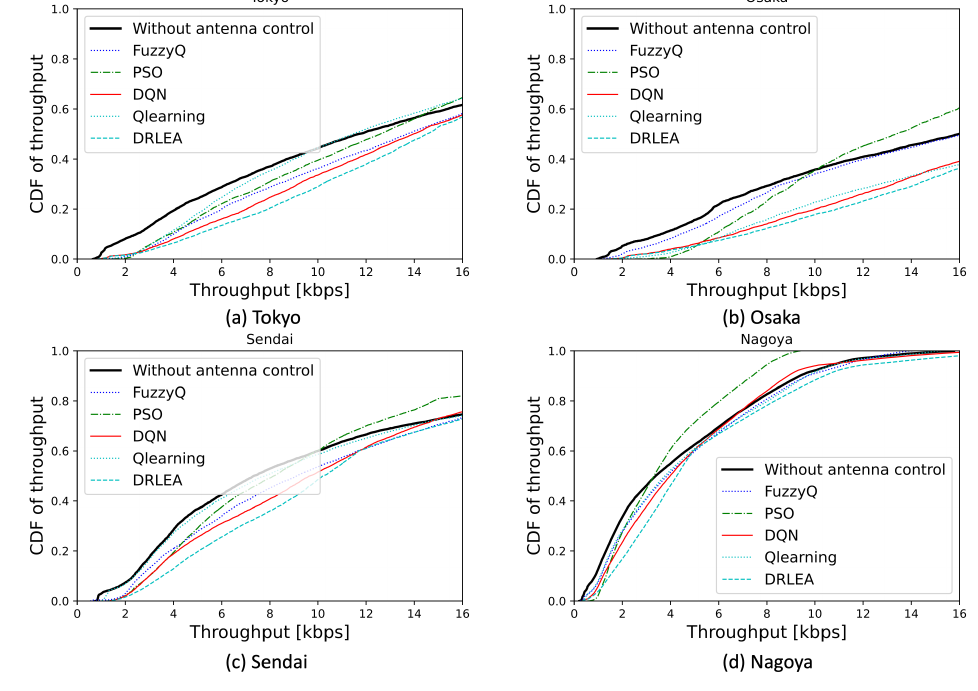
Figure 9. CDF of UE throughput performance under the HAPS with